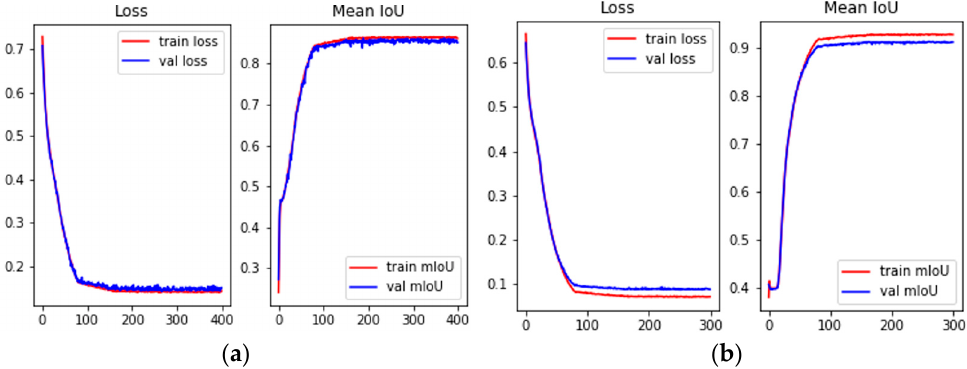
Figure 3. Training and validation on training images using mean intersection over union—mIoU as metric: ( a ) VGG-FCNs-CMU-96 × 96; ( b ) VGG-FCNs-Augment-96 × 96.